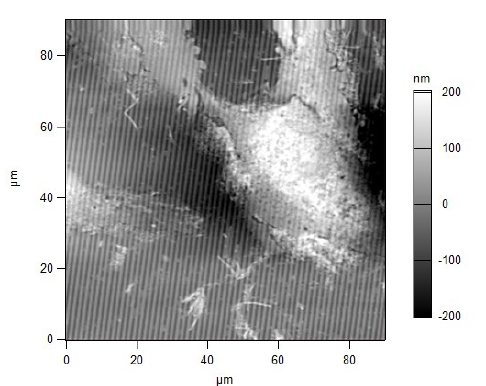
Figure 6. Infected Vero cell at 42 h p.i .; AFM scan of the diffraction grating. The SPR signal also decreased in this interval and reached its minimum around 30 h.